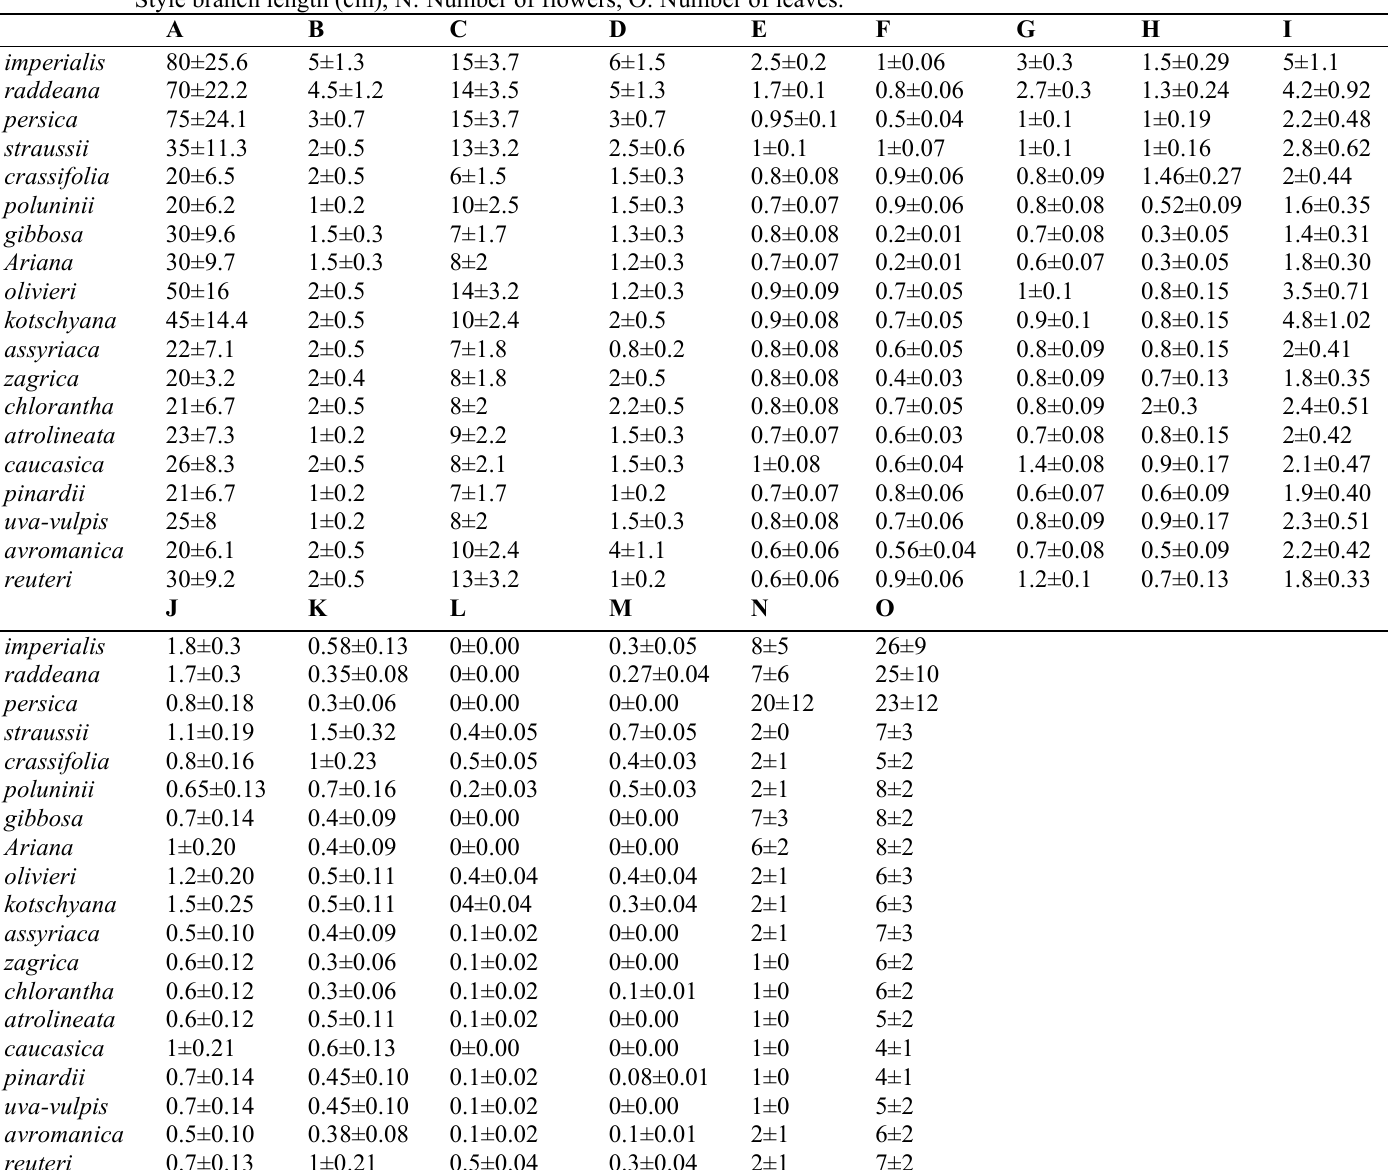
Table 2. Morphological characters in Fritillaria species, averages of measurements and standard deviations. A: Stem length (cm), B: Bulb diameter (cm), C: Lower leaf length (cm), D: Lower leaf width (cm), E: Length of filament (cm), F: Length of anther (cm), G: Length of style (cm), H: Length of ovary (cm), I: Length of tepal (cm), J: Width of tepal (cm), K: Nectary length (cm), L: Distance of nectary from base of tepal (cm),